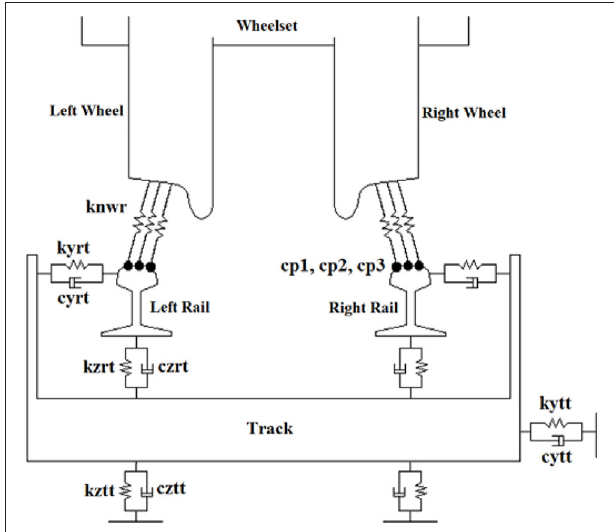
FIGURE 3 | Track and wheel/rail contact modeling. Souce: From Sun et al. (2017a). With permission of